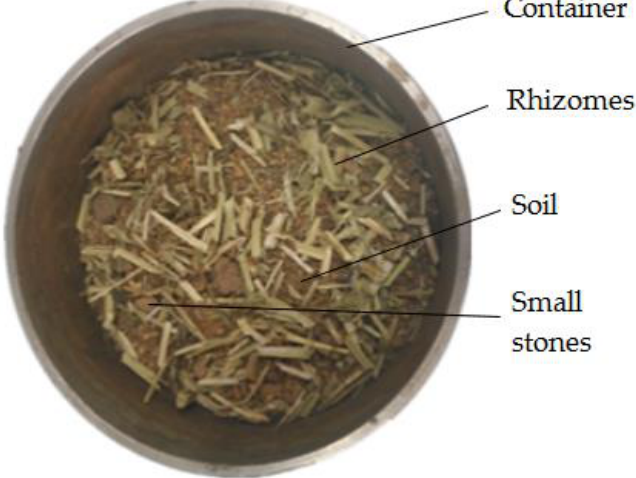
Figure 2. The actual situation of the wear test.